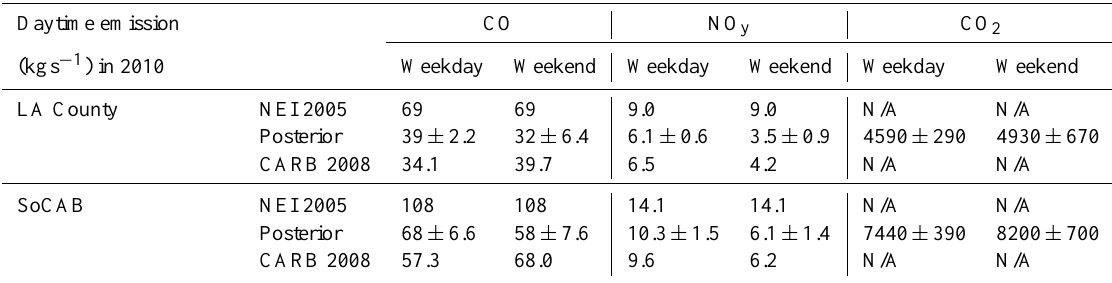
Table 3. Total daytime emissions (average from 17:00UTC to 01:00UTC, 10:00–18:00LT) of CO, NO y and CO 2 in Los Angeles County and the South Coast Air Basin (SoCAB) during weeday and weekend from NEI 2005 inventory, CARB 2008 inventory and the posteriors in 2010 from the inversion technique applied in this study. Based on NEI 2005 and Vulcan 2002 diurnal profiles, the daytime posterior estimates of CO, NO y and CO 2 can be multiplied by 0.7, 0.78 and 0.78, respectively, to convert them into daily average estimates, based on NEI diurnal profile.